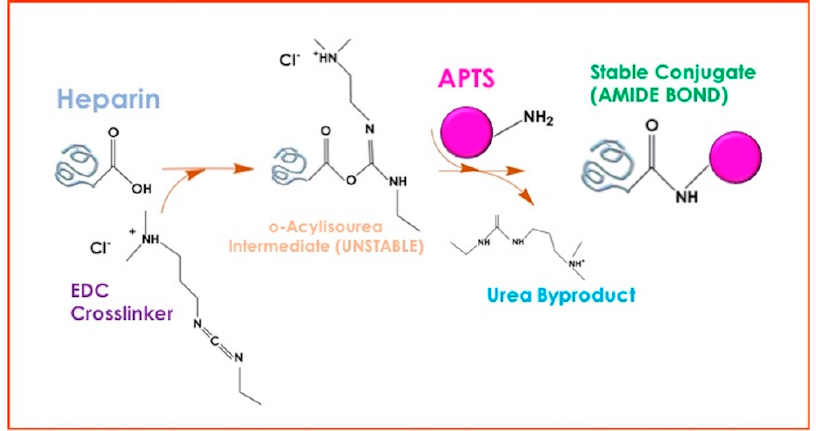
Scheme 1. Schematic illustration of amide bond formation between amino groups of APTS and carboxyl groups of heparin.